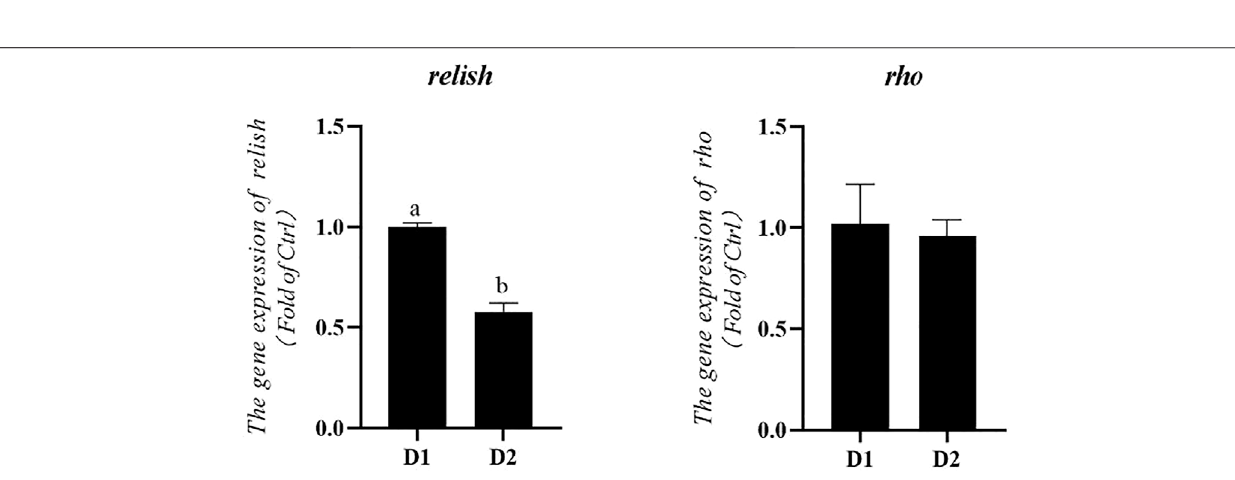
Frontiers in Physiology |